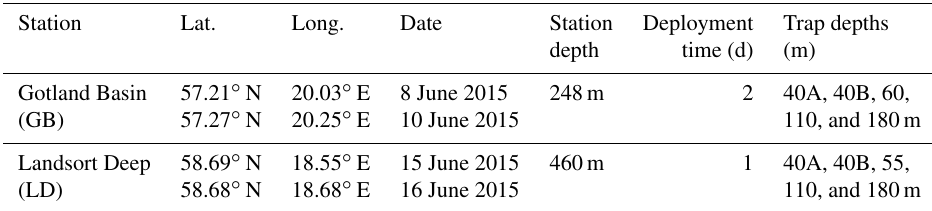
Table 1. Sediment trap deployment and recovery locations, dates, collection times and depths. Two sediment traps were deployed at 40m (A and B) to evaluate replicability.